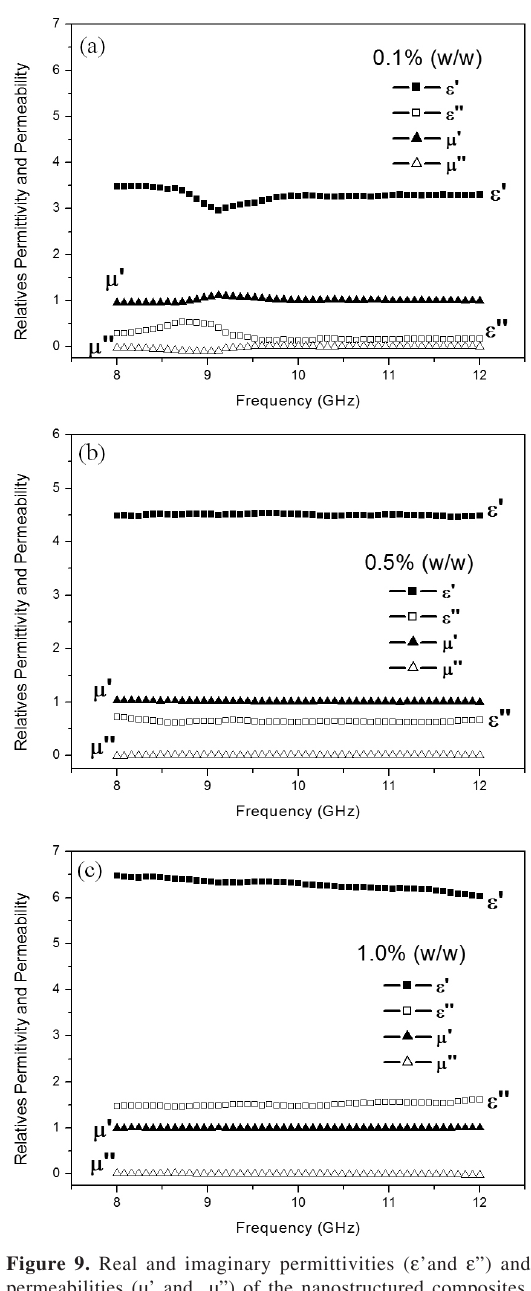
Figure 9. Real and imaginary permittivities ( ε ’and ε ”) and permeabilities (µ’ and µ”) of the nanostructured composites, formulations with CNTs versus frequency: (a) 0.1% (w/w), (b) 0.5% (w/w) and (c) 1.0%